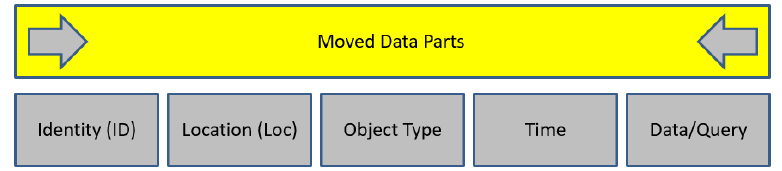
Figure 4. Main parts of generic IoT